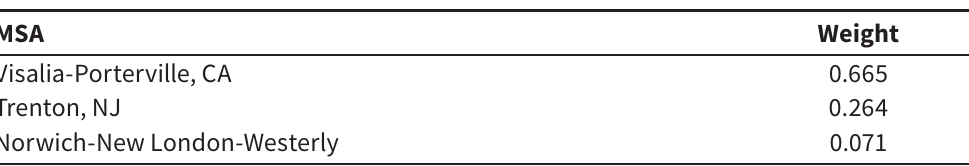
Weights for Constructing Synthetic Accommodation and Food Industry